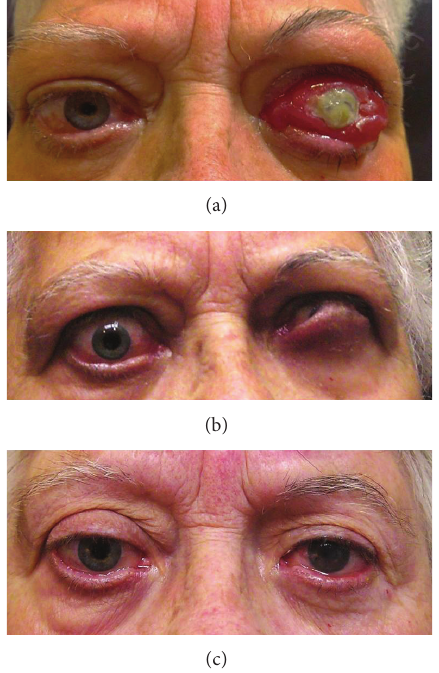
Figure 4: Threatening-to-vision GO. (a) Initial presentation of a patient with threatening-to-vision GO. LE: corneal breakdown, chemosis, conjunctival redness, eyelid swelling, swollen caruncle, retrobulbar ache at rest and with gaze, diurnal variation (inflamma- tory score: 9/10), proptosis > 2 mm, optic neuropathy, and extraoc- ular muscle restriction (3/3 progression score). (b) Appearance after methylprednosolone IV treatment, amniotic membrane transplant, and lateral tarsorrhaphy in LE. (c) Appearance after bilateral orbital decompression and levator recession surgery (Dr. Barrio-Barrio and Dr. Fernandez-Hermida performed the surgical